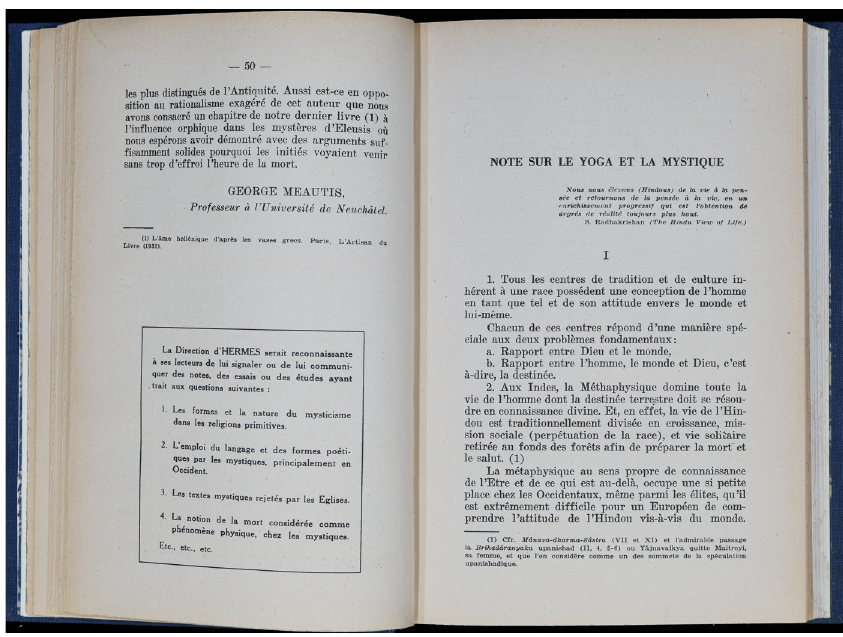
Fig. 4 Hermès 1.1 (1933), p.